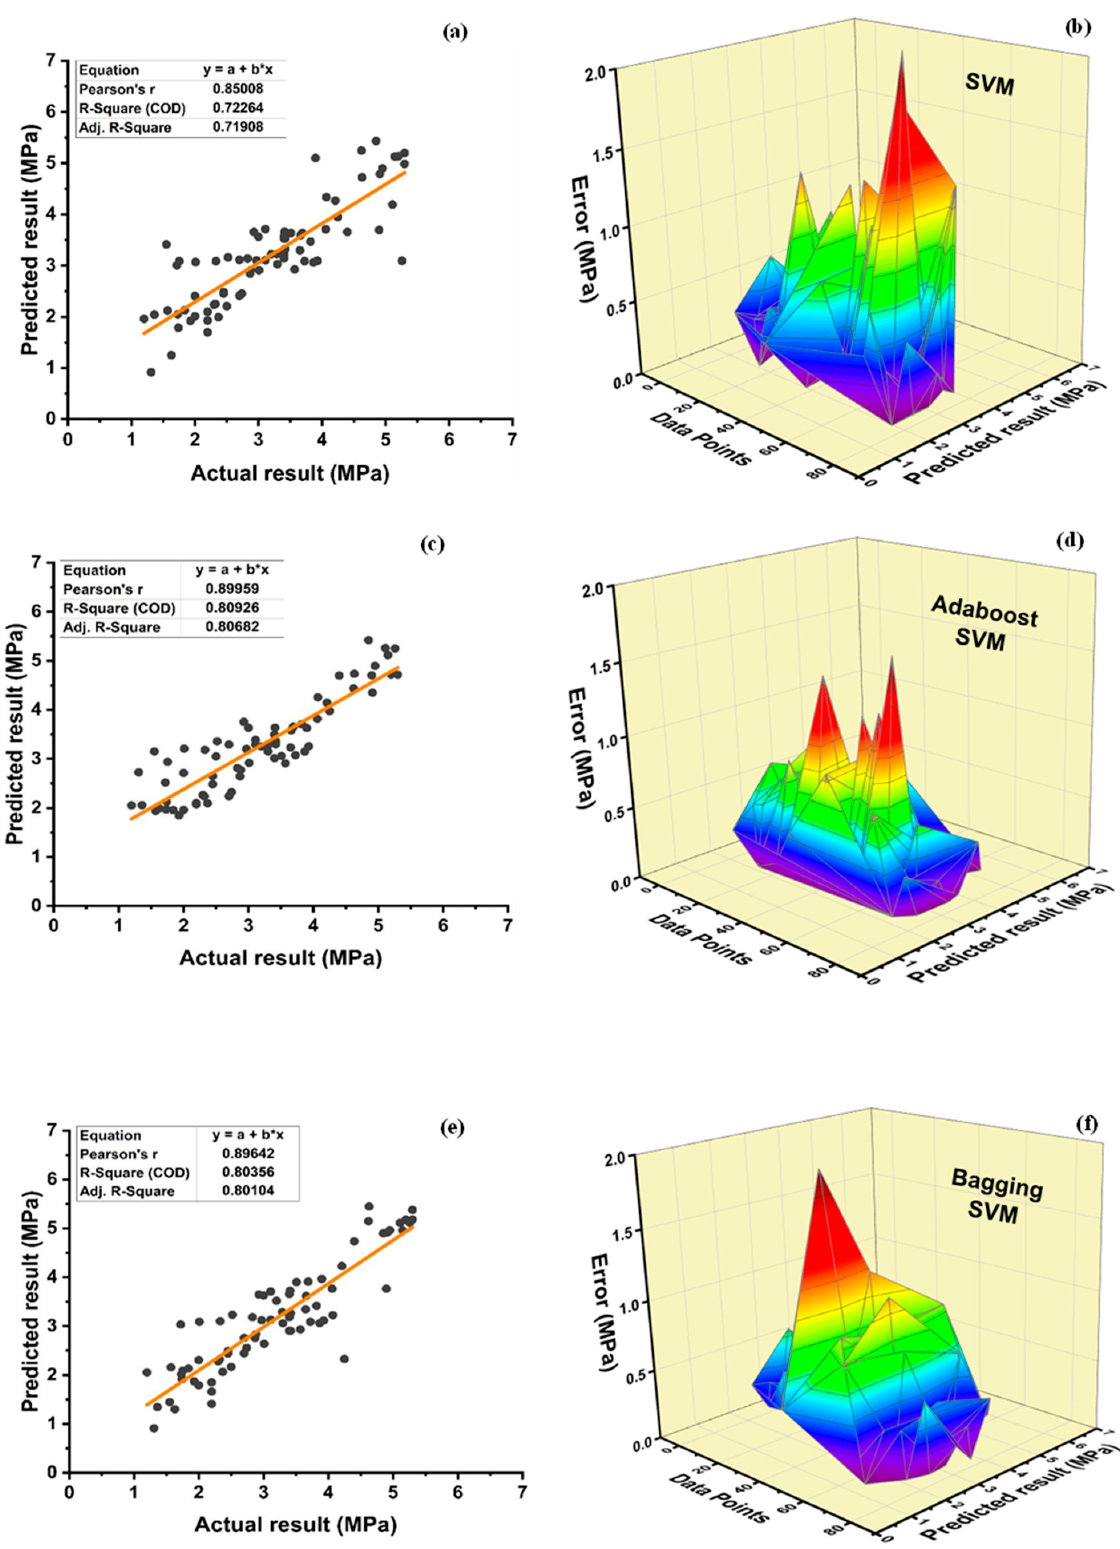
Figure 17. Tensile strength: ( a ) SVM regression model; ( b ) SVM regression model error distribution; ( c ) SVM-Adaboost regression model; ( d ) SVM-Adaboost regression model error distribution; ( e ) SVM-Bagging regression model; ( f ) SVM -Bagging regression model error distribution .